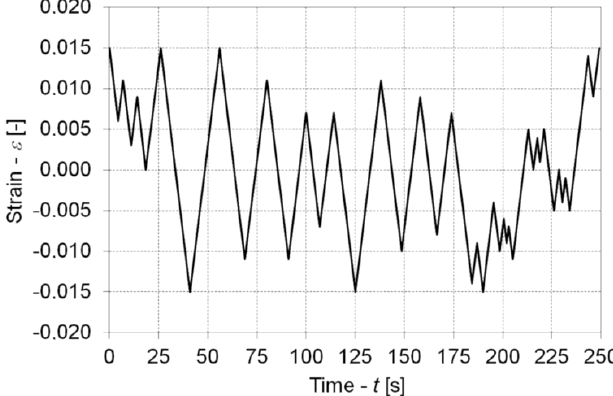
Figure 5. Strain time series for the second random-loading experiment.